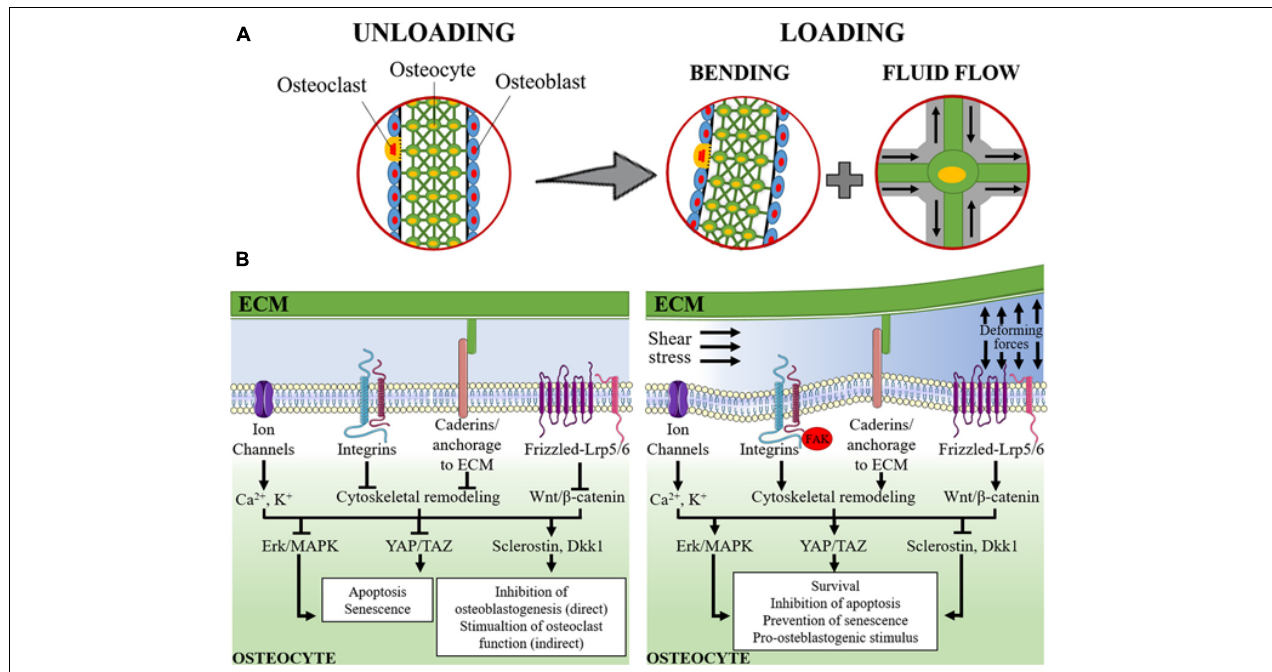
FIGURE 1 | Schematic representation of mechanosensing in osteocytes. (A) The lacuno-canalicular system is schematically modeled with osteocytes (green cells) that take contact with adjacent osteocytes, within the bone matrix, and with osteoblasts (light blue cells) and osteoclasts (yellow cells) on the surface of the bone segment. On the left, it is represented the rest status (unloading). On the right it is represented the loading condition: the applied forces cause the bending of the bony segment while, within the lacuno-canalicular system, the interstitial fluid is redistributed and its flow submits osteocytes to shear stress and change in extracellular pressure. (B) The signaling pathways activated under unloading (left) and loading (right) conditions are schematically represented. During unloading, pro-apoptotic and pro-senescence pathways are activated (consequently to the inhibition of Erk/MAPK and YAP/TAZ) together with the induction of sclerostin and Dickkopf-related protein 1 (Dkk1). These latter mediators are released into the intercellular fluid and reach osteoblasts and pre-osteoblasts where they exert their anti-osteoblastogenic effects, thereby, indirectly favoring the osteoclast function. During loading, the applied forces and the intra-canalicular fluid shear stress cause the deformation of the osteocyte plasma membrane and of the extracellular matrix (ECM). This results in: (i) perturbation of the electrolyte homeostasis (Ca 2 + and K + ); (ii) activation of cadherin and integrin-mediated signaling and the associated focal adhesion kinase (FAK) pathway that result into the remodeling of the cytoskeleton; and (iii) activation of the Wnt/ β -catenin signaling. The downstream signaling determines the activation of Erk/MAPK and YAP/TAZ that, together with the inhibition of the expression of sclerostin and Dkk1, result into the stimulation of osteocyte survival, inhibition of apoptosis and prevention of senescence and, in turn, a support to osteoblastogenesis and osteoblast